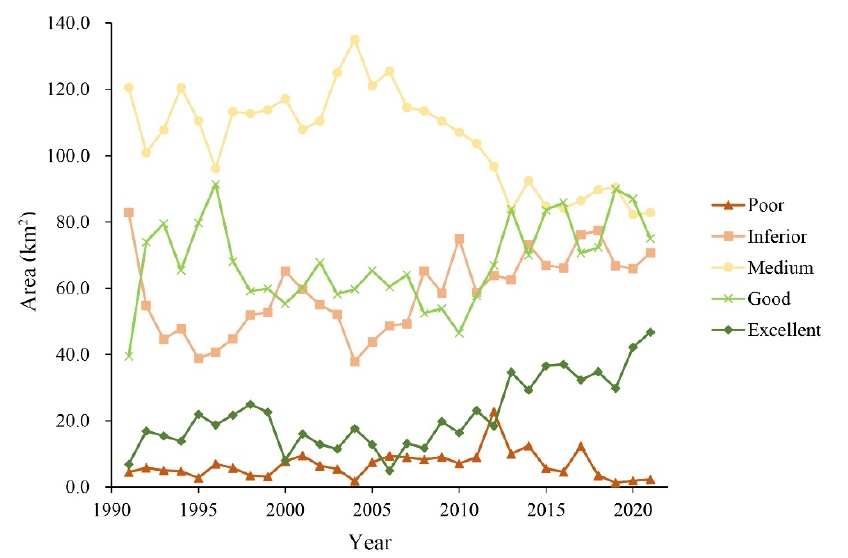
Figure 5. Area statistics of remote sensing-based ecological index (RSEI) at different levels from 1991 to 2021. The area of RSEI in Figure 4 is without water.